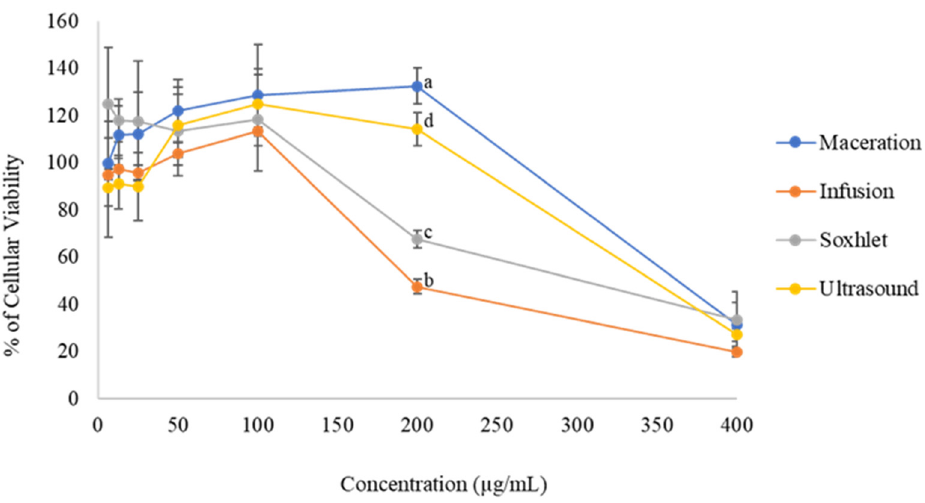
Figure 3. Cell viability percentage of rosemary extract in HaCaT cells obtained by maceration, infusion, Soxhlet, and ultrasound at 400, 200, 100, 50, 25, 12.5, and 6.25 µg/mL concentrations. Results are presented as average ± standard deviation, n = 3. The letters represent significant differences between samples.